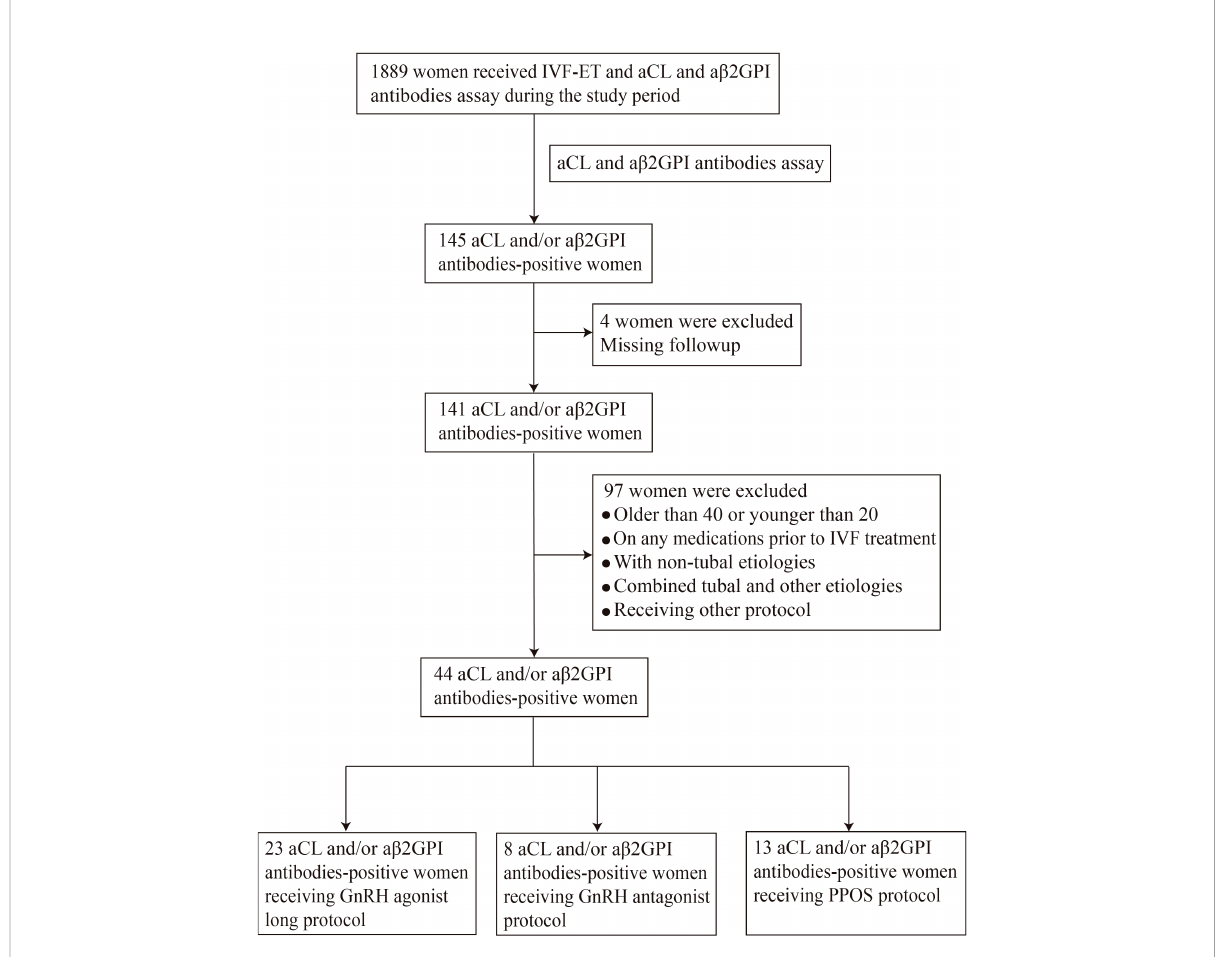
FIGURE 1 The patient selection scheme for aCL and/or a b 2GPI antibody (aPL) positive